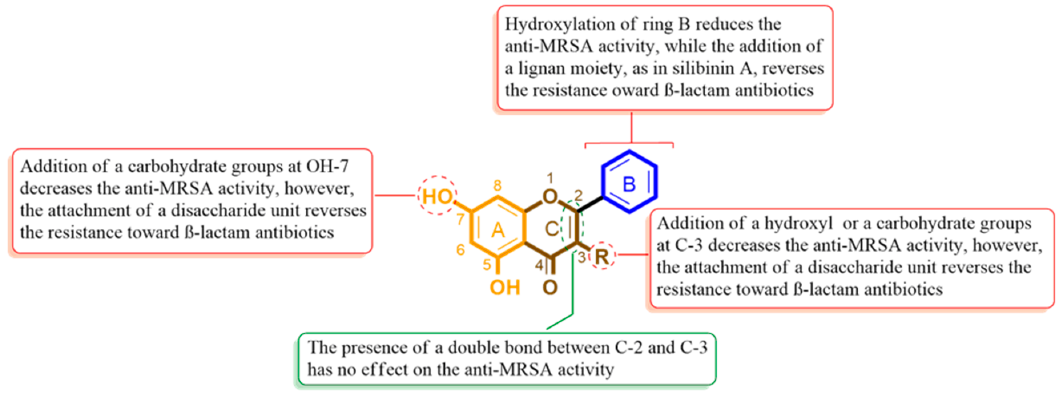
Figure 8. Structure-Activity Relationship (SAR) of the flavonoid scaffold indicates the possible structural features required for the inhibitory and synergistic effects of MRSA.